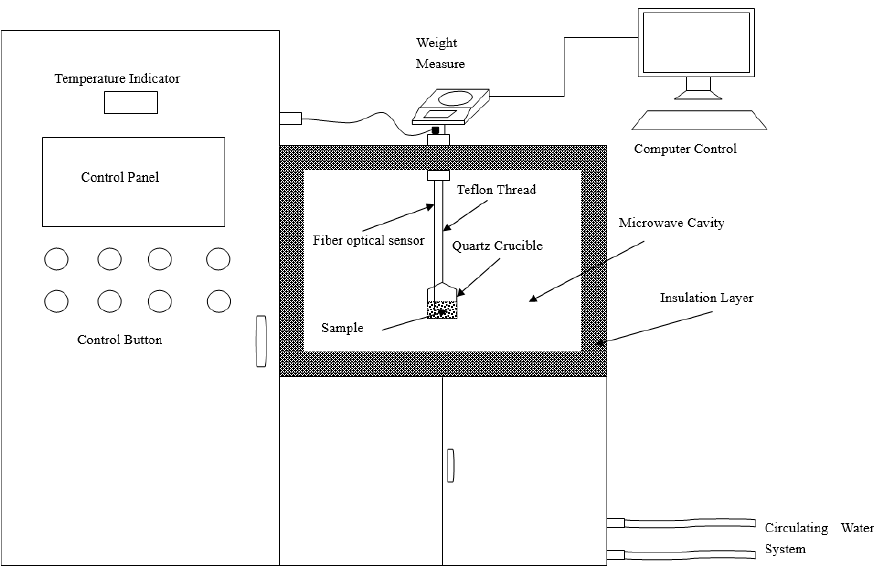
Figure 1. Schematic illustration of the microwave heating system.